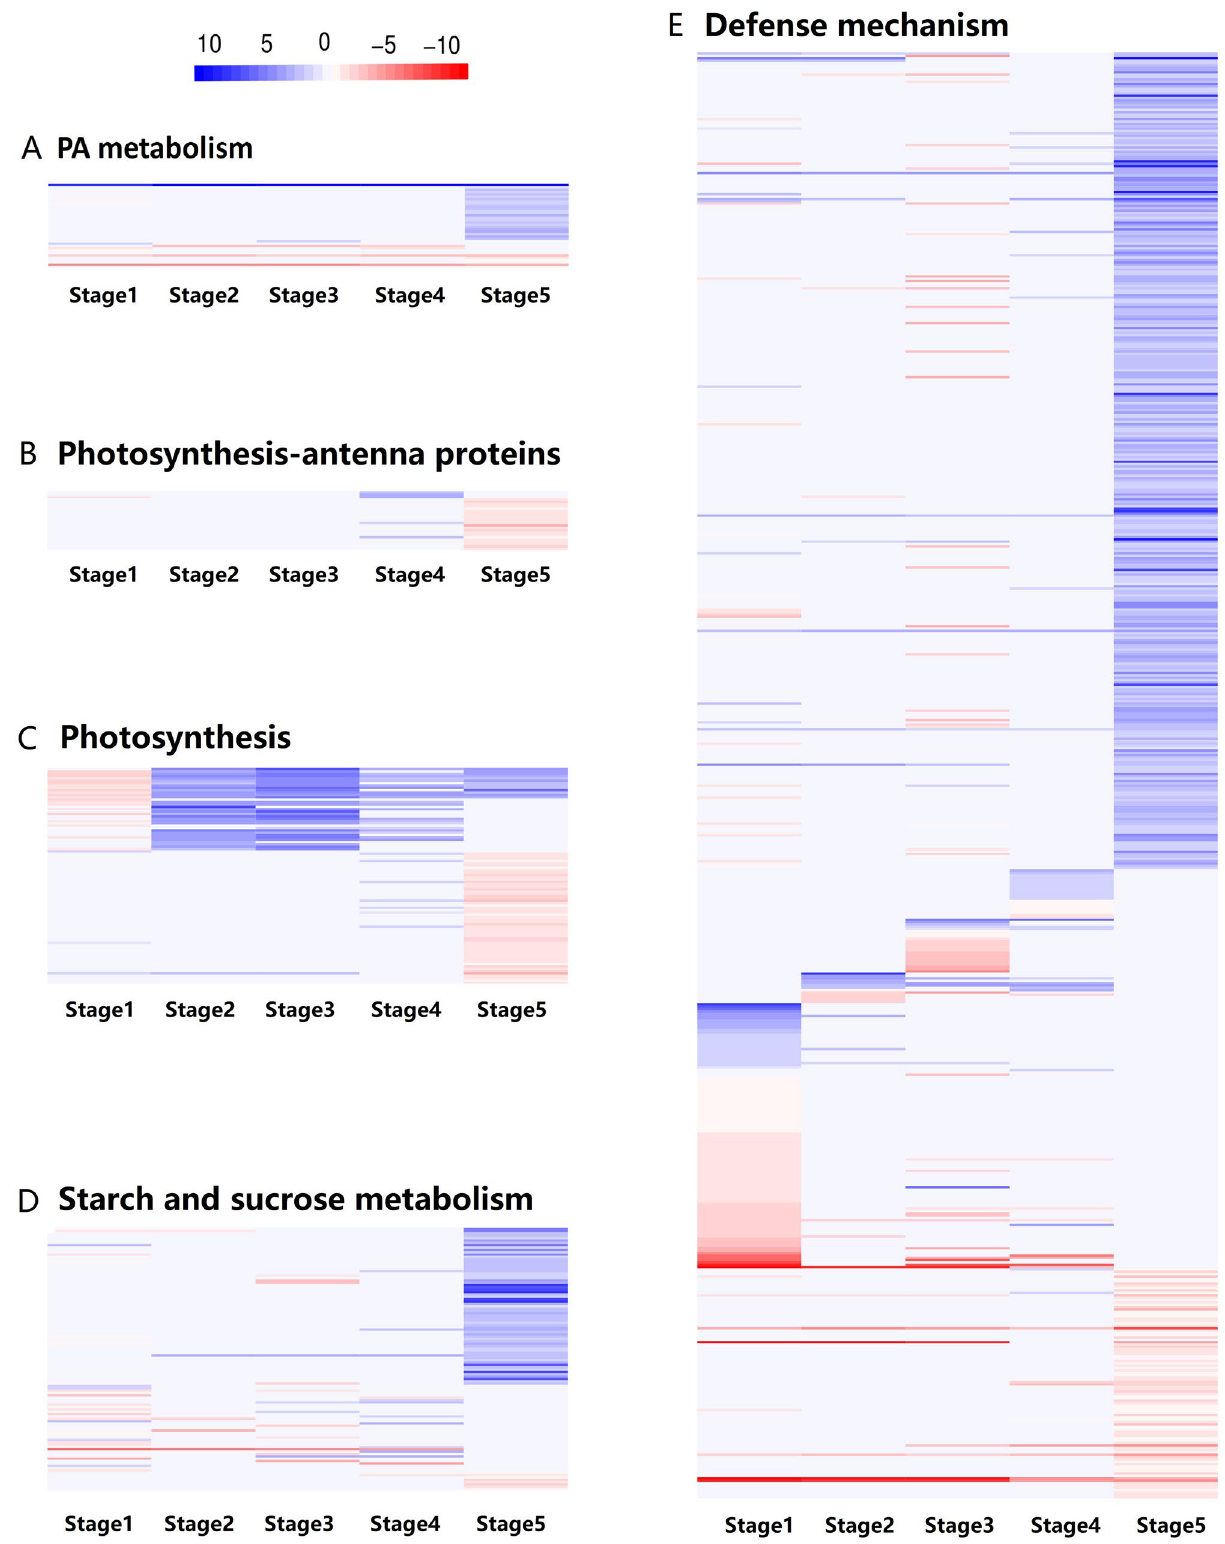
Figure 4. Fold-change ( 2mlpa over 2MWT) ratios in five seed developmental stages for the DEGs associated with ( A ) PA metabolism, ( B ) photosynthesis-antenna proteins, ( C ) photosynthesis, ( D ) starch and sucrose metabolism, and ( E ) defense mechanisms. Rows represent DEGs between the 2mlpa and 2MWT soybean lines, whereas columns represent the five seed developmental stages. Blue and red indicate up-regulated and down- regulated expression ( 2mlpa over 2MWT),